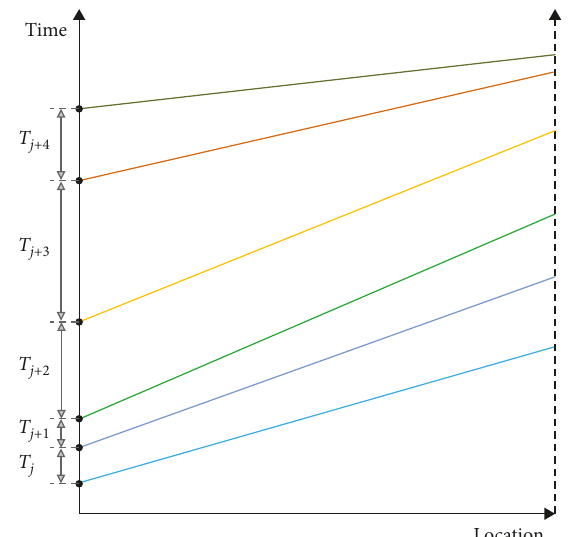
Figure 1: Diagram of adjacent inspection intervals for different inspection